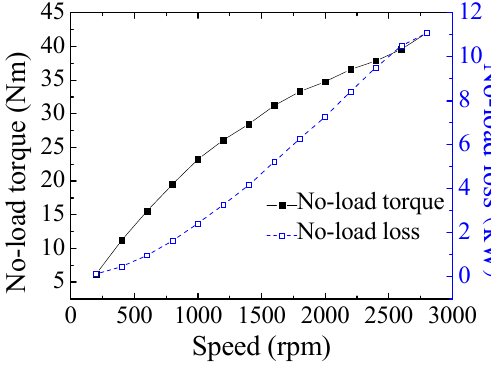
Figure 18. Variation of average torque and no-load loss versus the shaft